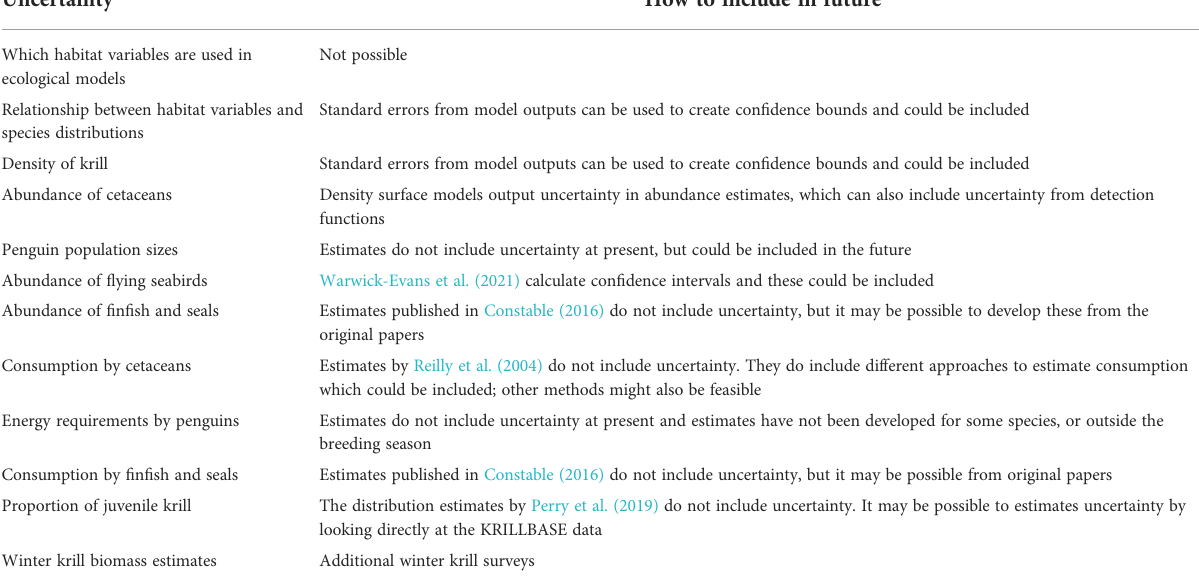
TABLE 2 A list of uncertainties present in each aspect of the risk assessment framework and how each may be included in future iterations. .